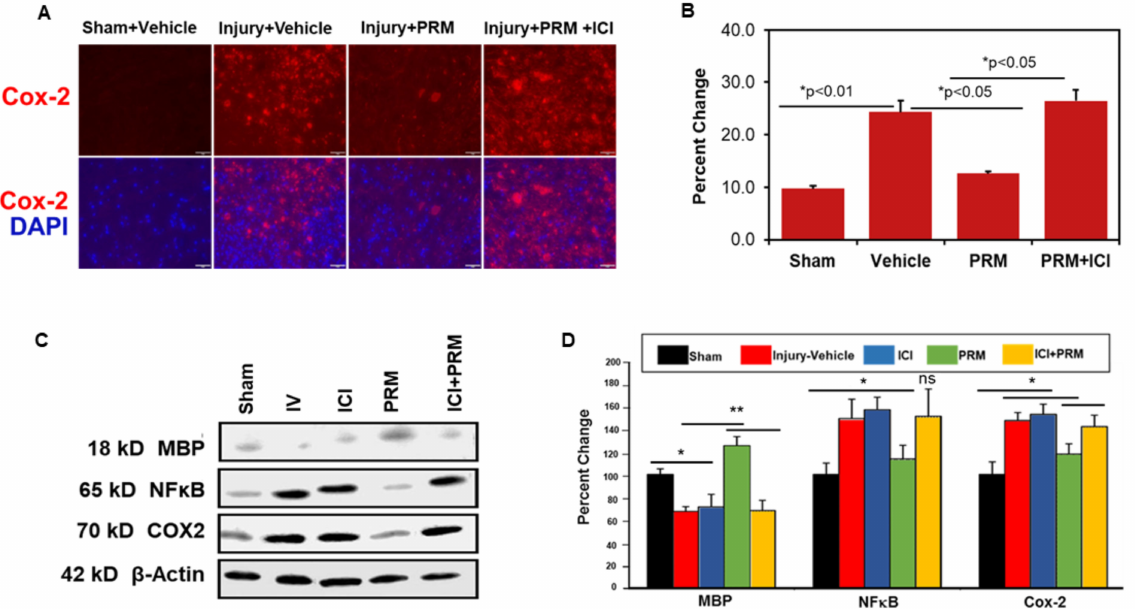
Figure 6. PRM decreased inflammation and reversed myelin loss at day 7 after SCI. Immunostaining indi- cates reduced levels of COX-2, a major inflammatory mediator following PRM treatment compared to vehicle-treated rats ( A , B ), and this was shown in western blot analysis as well ( C , D ).